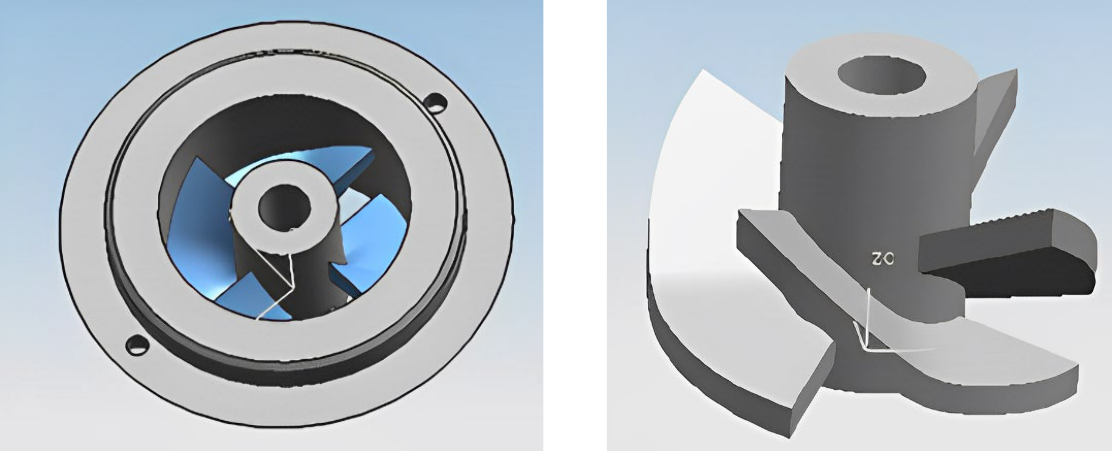
Figure 23. Water injection drain cone [38].